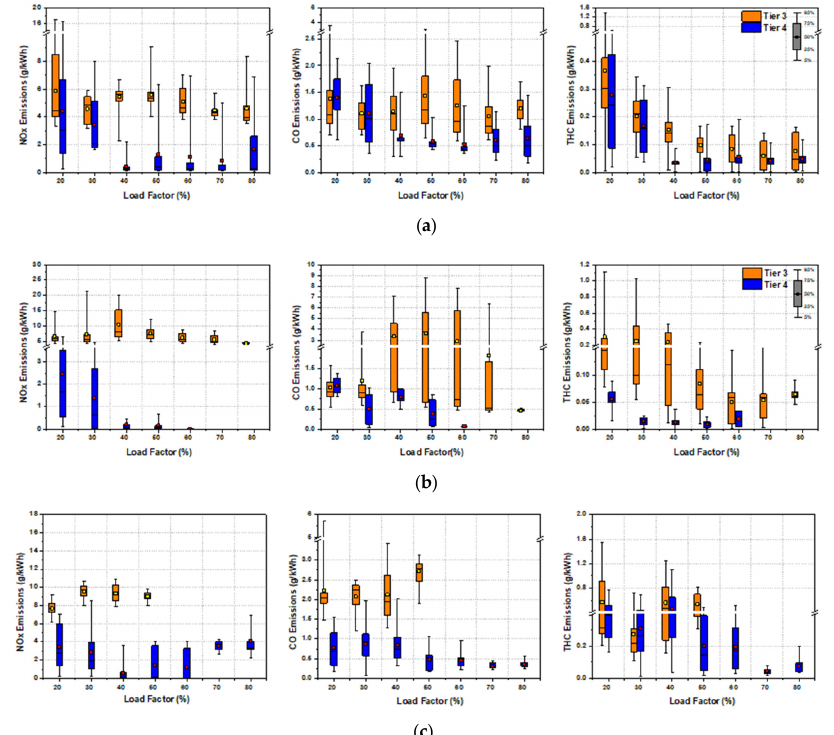
Figure 8. Three gaseous emissions with concern of load factor for the difference types of construction machines. ( a ) Excavators; ( b ) Wheel Loaders; ( c ) Fork-lift.